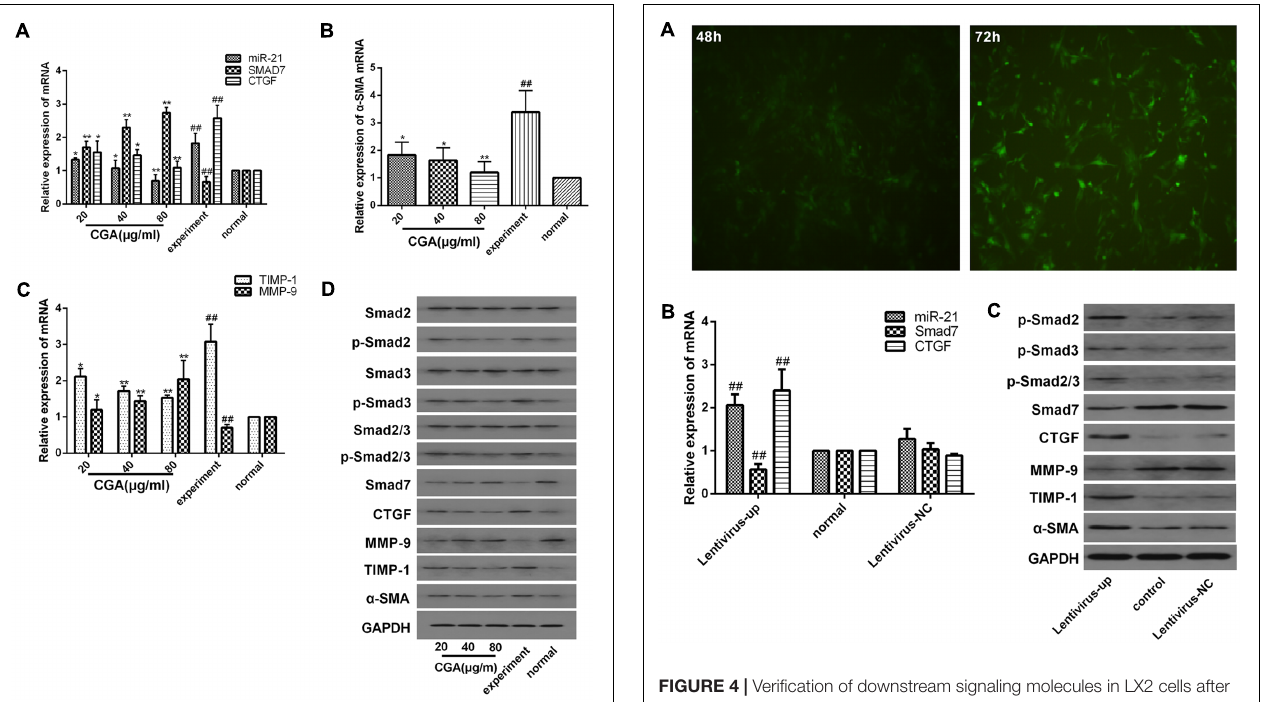
FIGURE 4 | Verification of downstream signaling molecules in LX2 cells after miR-21 overexpression. (A) LX2 cells were transfected with lentivirus, and the expression of GFP was observed with a fluorescence microscope after 48 and 72 h. (B) The expression of miR-21, Smad7 and CTGF were measured by quantitative real-time PCR. (C) The protein expression was detected by western blotting. Data are shown means ± SD and significant differences were determined by one-way ANOVA. ## P < 0.01 for lentivirus-up group vs. normal